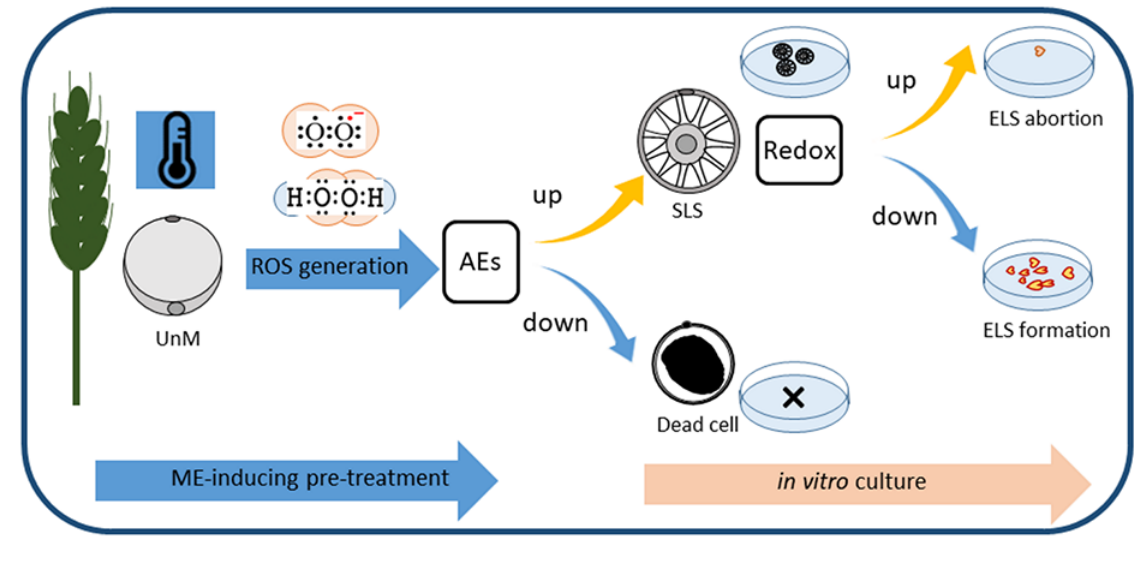
Figure 2 Determinants of successful induction of microspore embryogenesis (ME) in isolated microspore cultures of triticale (× Triticosecale Wittm.). Low temperature treatment (3 weeks at 4 °C) – a standard trigger of ME – applied to tillers containing uninucleate, totipotent microspores (UnM) is associated with generation of reactive oxygen species (ROS), necessary for microspore reprogramming. High activity of antioxidative enzymes (AEs) sustains microspore viability and allows for effective ME induction (visible in high number of star-like structures, SLS). Decreased activity of AEs frequently results in cell death. However, even high viability of microspores does not ensure final success as the next stages of embryogenic development require a more oxidized environment (lower redox